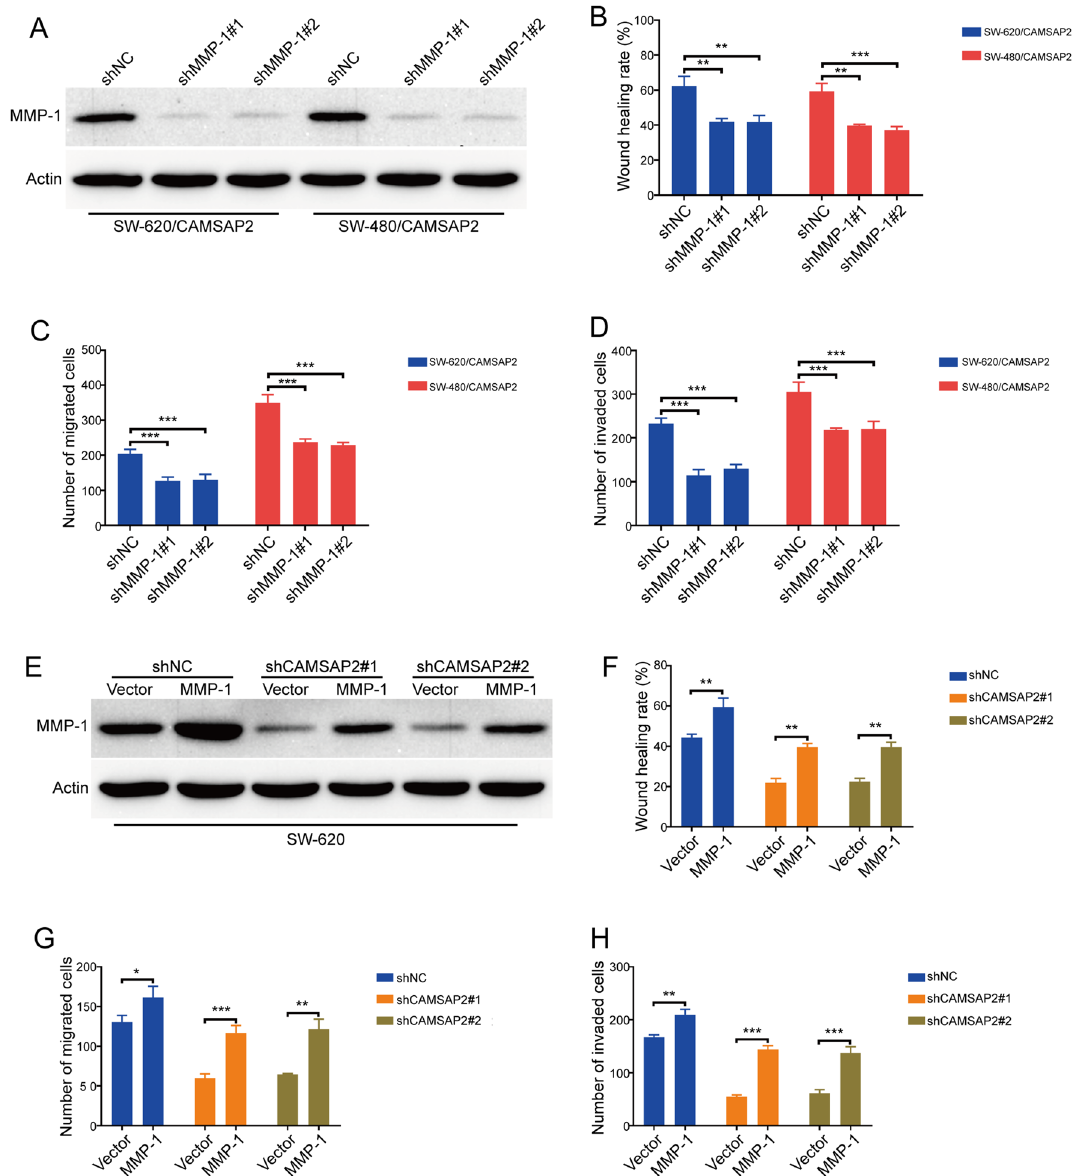
Figure 5. MMP-1 was essential for CAMSAP2-induced migration and invasion in colorectal cancer cells. ( A ) Western blot analysis showed that MMP-1 was silenced by shRNA against MMP-1 in CAMSAP2-overexpessing SW-620 cells. ( B ) Wound healing scratch assay showed ectopic expression of MMP-1 attenuated CAMSAP2 shRNA-reduced migration in SW-620 and SW-480 cells. Left: representative images of wound scratch. Right: histograms represent the analysis of the wound healing rate. ( C ) Transwell migration assay showed overexpression of MMP-1 attenuated the inhibition of CAMSAP2 shRNA on colorectal cancer cell migration. ( D ) Enforced overexpression of MMP-1 restored the invasion-attenuated by CAMSAP2 shRNAs in colorectal cancer cells. ( E ) Western blot analysis of MMP-1 expression in CAMSAP2-silenced SW-620 and SW-480 cells transduced with MMP-1 plasmid (MMP-1) or empty vector (Vector). ( F ) Wound healing assay showed silencing MMP-1 attenuated CAMSAP2-induced migration in colorectal cancer cells. Left: representative images of wound scratch. Right: histograms represent the analysis of the wound healing rate. ( G ) Transwell migration assay showed knockdown of MMP-1 attenuated the CAMSAP2-induced migration in SW-620 cells. (H) Knockdown of MMP-1 inhibited the colorectal cancer cell invasion induced by CAMSAP2 overexpression. * P < 0.05; ** P < 0.01; ***P <